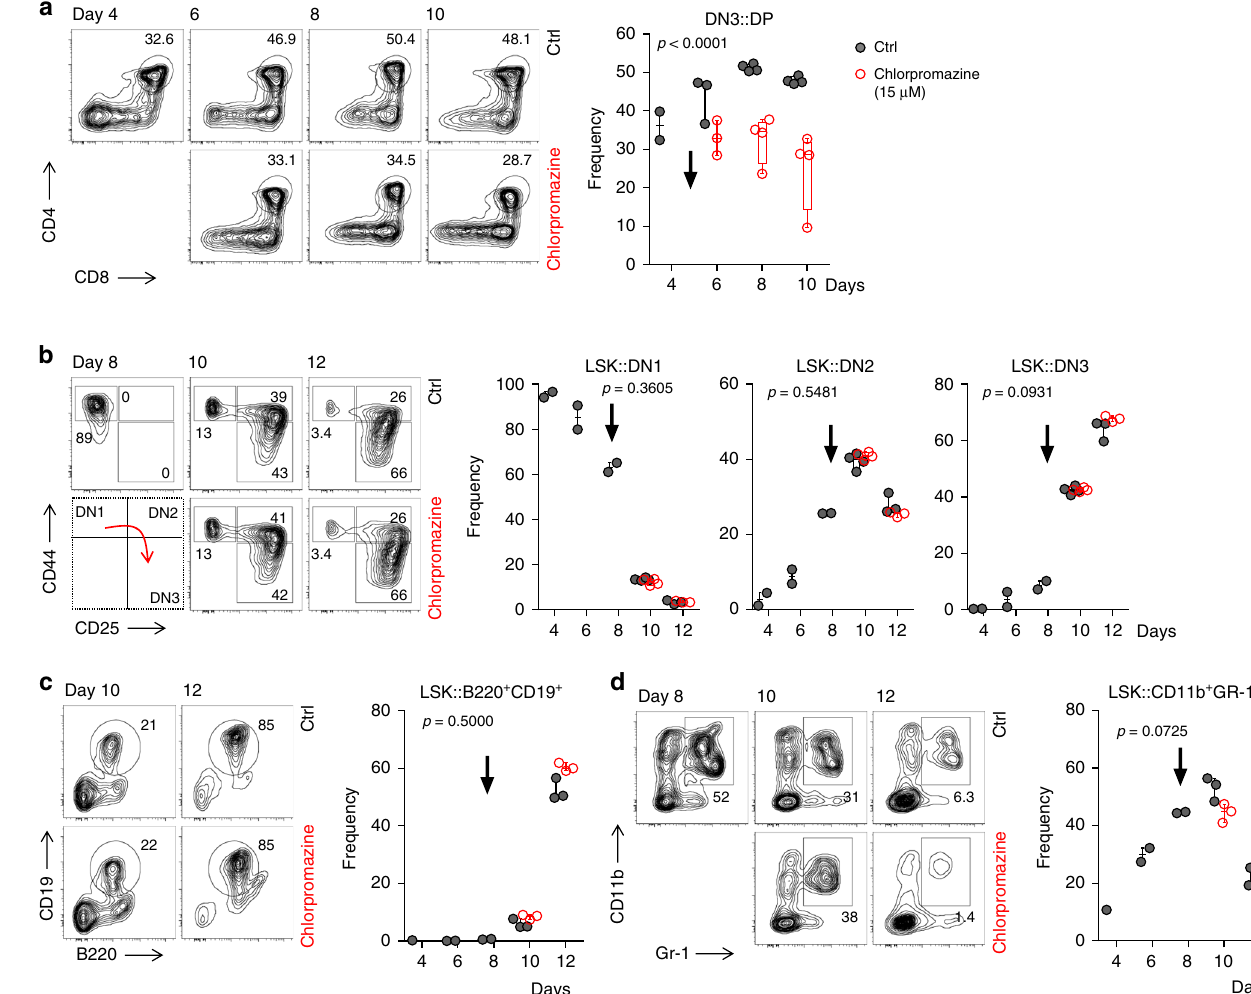
Fig. 7 Chlorpromazine-induced inhibition of CME arrests development of thymocytes. a Thymi-derived double-negative three progenitors (DN3: CD4 − CD8 − CD44 + CD25 − ) were sorted and cultured on OP9-DL1 stroma cells in the presence of Flt-3L, SCF and IL-7. At day 5 of co-culture cells were left untreated (ctrl) or treated with chlorpromazine (15 µ M) to partially inhibit CME (chlorpromazine IC 50 for CME was established at 17.4 µ M 35 ). Subsequently, development of double-positive (DP: CD4 + CD8 + ) progenitors was assessed by FACS (left) and quanti fi ed (right). b Bone marrow-derived LSK progenitors (lineage − Sca-1 + CD117 + ) were sorted and cultured on OP9-DL1 stroma cells in the presence of Flt-3L, SCF and IL-7. Analogous to a , at day 8 of culture cells were left untreated (ctrl) or treated with 15 µ M chlorpromazine. Effect of partial CME inhibition on early-thymocyte progenitor development was assessed by FACS. Double-negative (DN) cells were de fi ned as follows: DN1 – CD44 + CD25 − ; DN2 – CD44 + CD25 + and DN3 – CD44 − CD25 + . c , d Bone marrow-derived LSK progenitors (lineage − Sca + 1 − CD117 + ) were sorted and cultured on OP9 stroma cells in the presence of Flt-3L, SCF and IL-7. At day 8 of culture cells were left untreated (ctrl) or treated with chlorpromazine (15 µ M) to partially inhibit CME. Subsequently, development of c B-cell committed progenitors de fi ned as B220 + CD19 + and d granulocytes (CD11b int − hi Gr-1 + ) was assessed by FACS (left) and quanti fi ed (right). a – d Density FACS plots and charts are representative of two independent experiments where one to four wells were measured at each indicated time point. Number adjacent or within the gates indicate frequency. Each dot on the chart represents one well. Whiskers indicate the range (min to max). Arrows indicate time points when chlorpromazine was added. Statistical analysis was performed using two- way ANOVA ( p -values for effect of chlorpromazine). Source data are provided as a Source Data fi